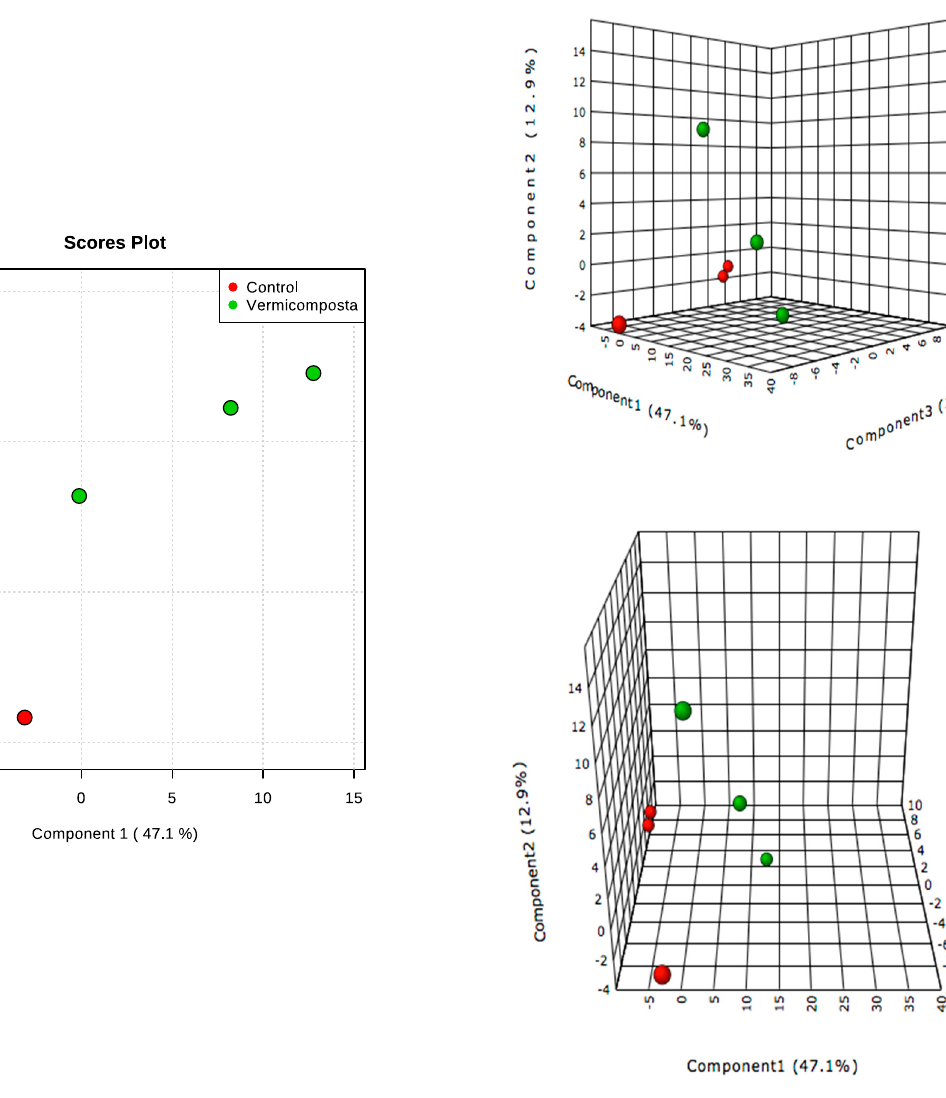
Figure 5. PLS-DA of samples amended with vermicompost vs. samples from the control group.